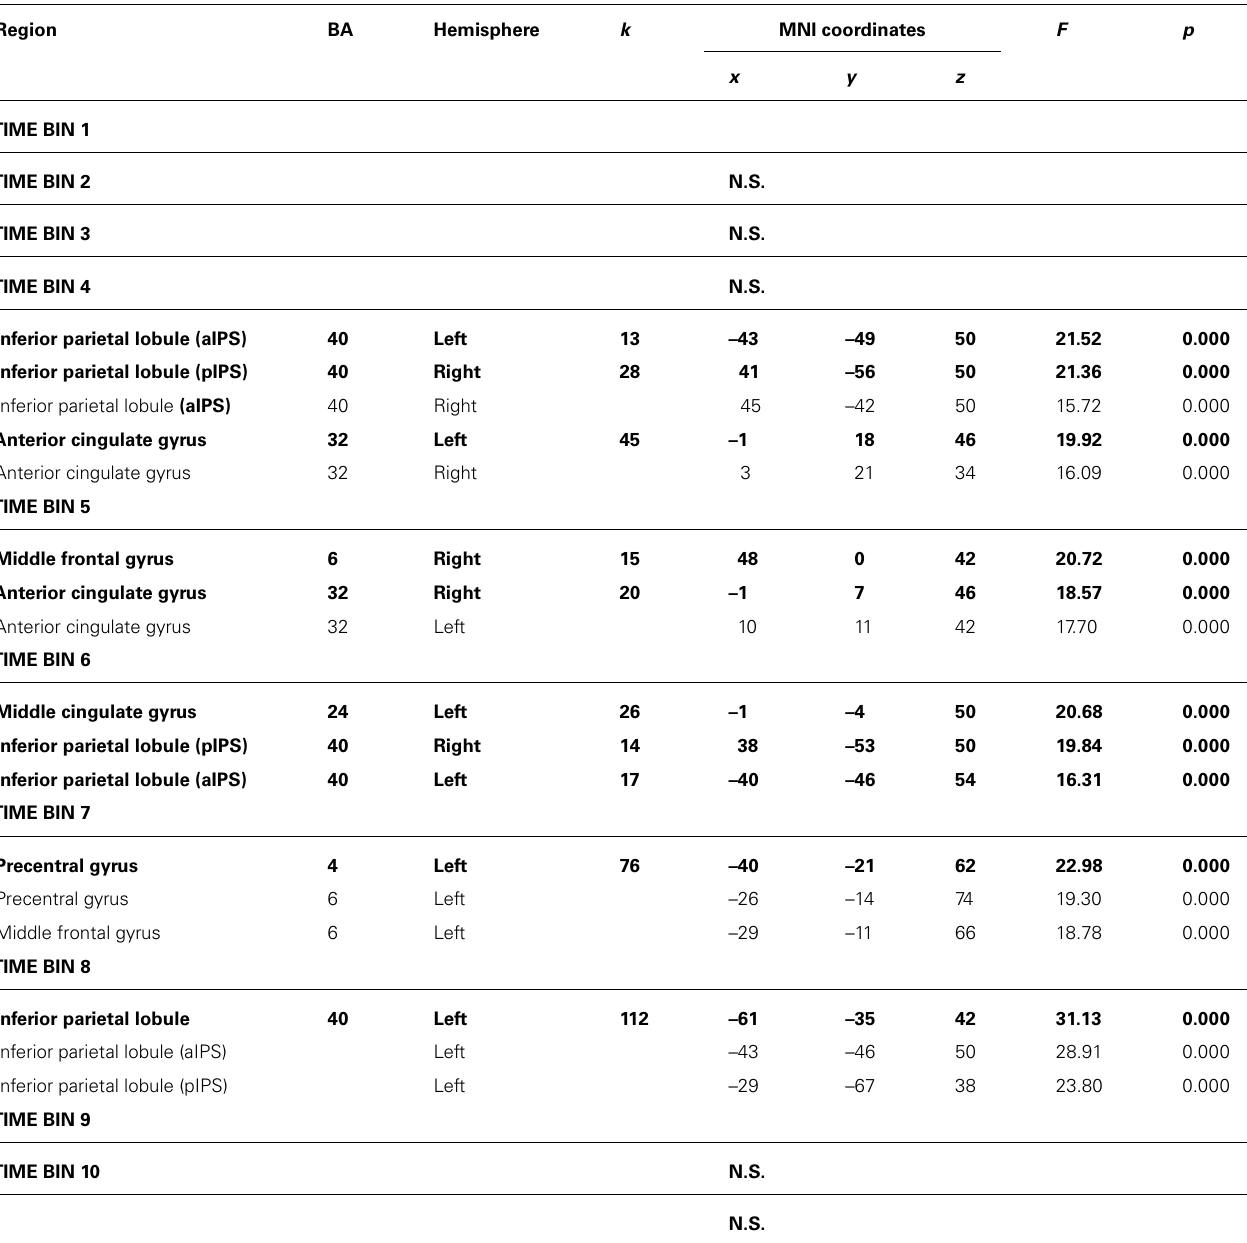
Table 2 | Brain regions showing interaction effects between type of movement (grasping, reaching) and stimulus dimension (small, large) distinguished in singleTime Bins. Region BA